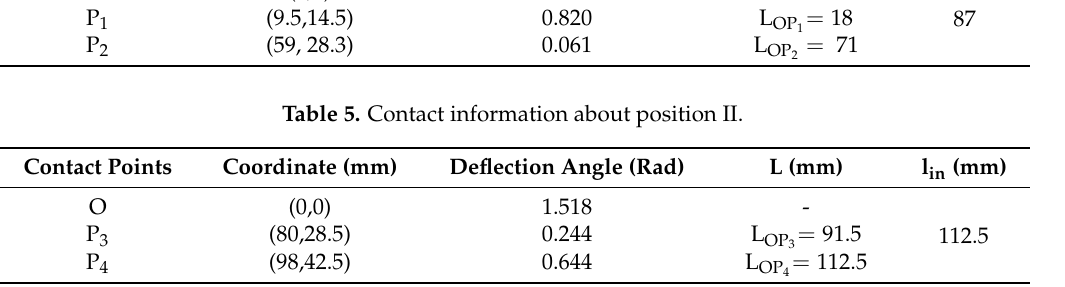
Table 4. Contact information about position I.